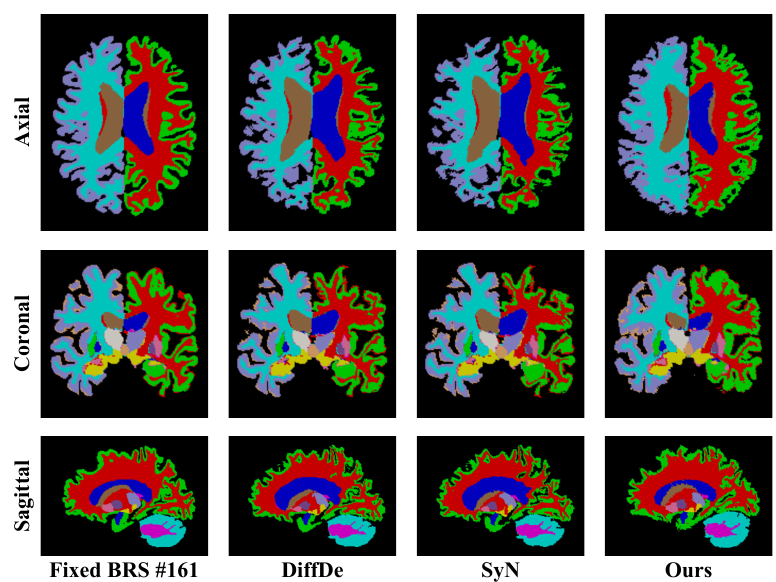
Figure 6. The qualitative results of Section 3.3 are shown. The first to third rows display the BRSs of the axial, coronal, and sagittal sections, respectively. The first column shows the fixed BRS of #161. The second to forth columns show the warped BRSs of the methods.